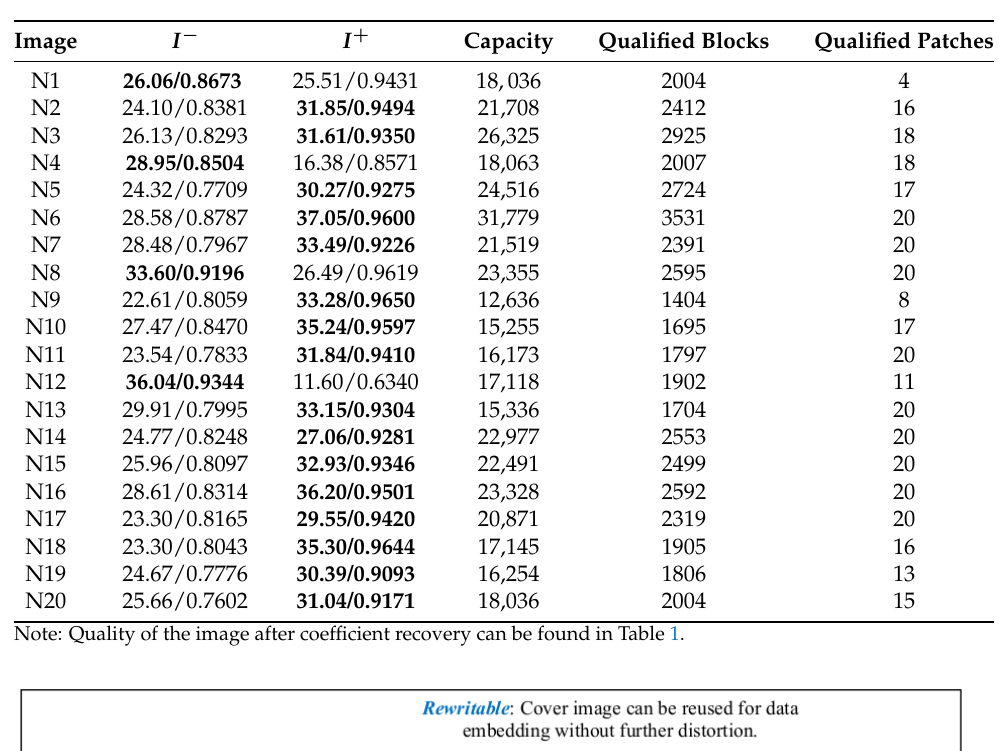
Table 2. Image quality after removal of coefficients ( I − ) and after data embedding ( I + ). Results for image quality are presented in the format of PSNR (dB)/SSIM. Capacity is recorded in the unit of bits. The number of qualified blocks and the number of qualified patches are recorded in the last 2 columns.